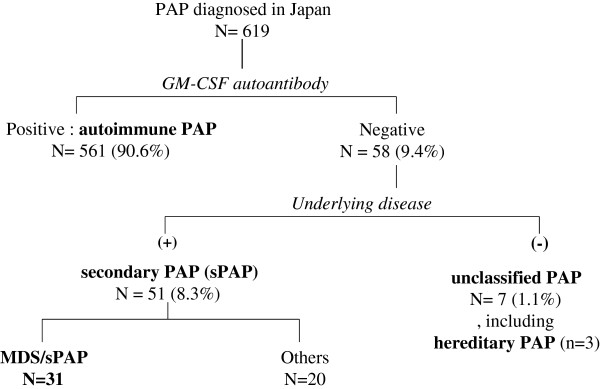
Disposition of patients with pulmonary alveolar proteinosis (PAP) who were enrolled into this study. Participants were stratified according to the presence or absence of granulocyte/macrophage-colony stimulating factor (GM-CSF) autoantibody, and then according to the presence or absence of an underlying disease known to cause PAP.